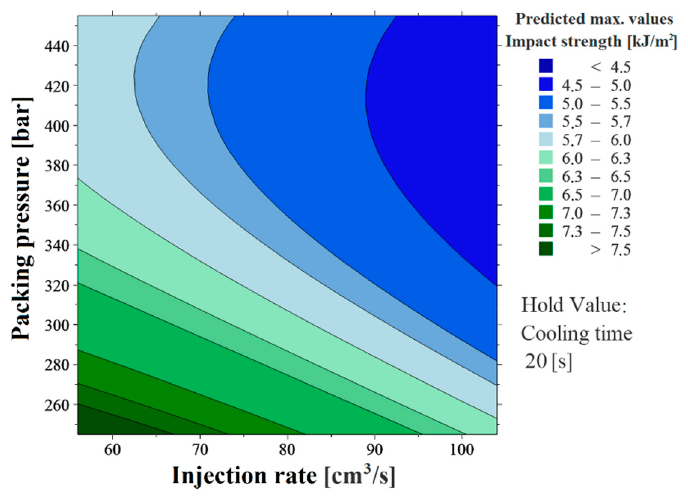
Figure 10. Impact bending test response surface regression—contour plot of the result of specimens with parallel microstructures.